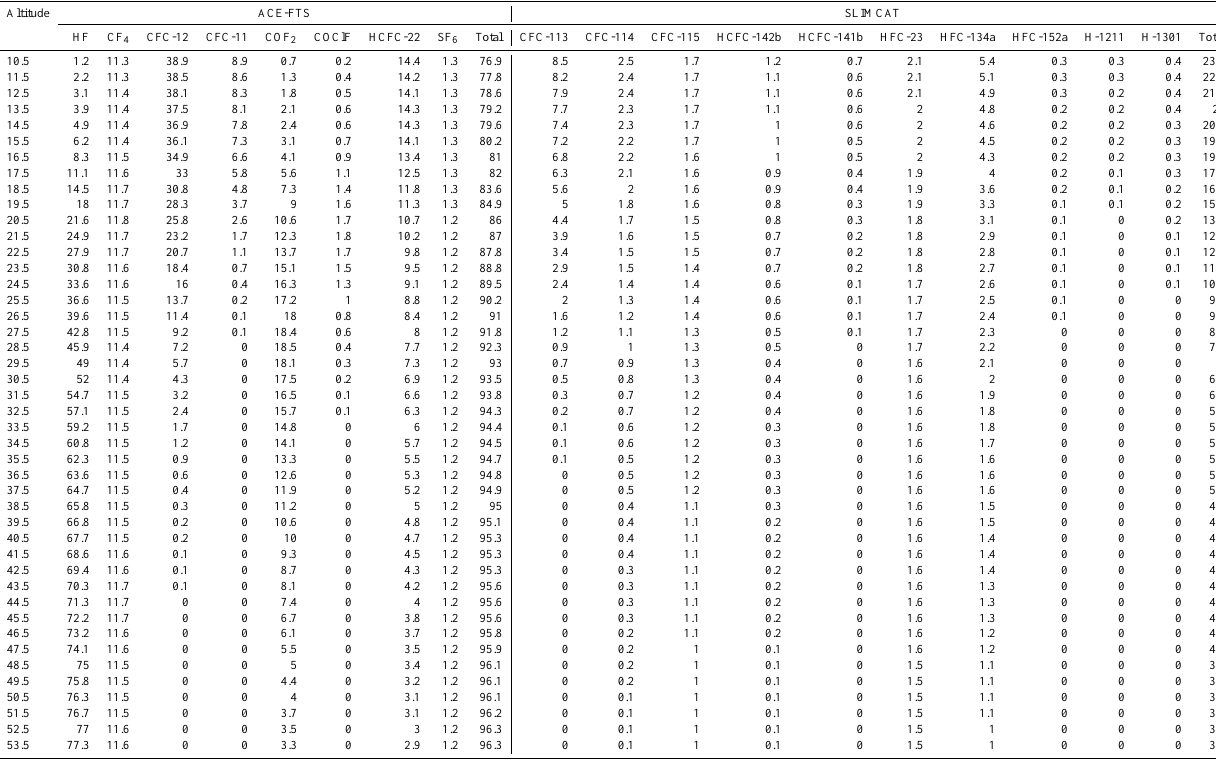
Table A1. The percentage contribution of each species to the total fluorine budget in the latitude bands between 70 ◦ N and 30 ◦ N. Altitude ACE-FTS SLIMCAT HF CF 4 CFC-12 CFC-11 COF 2 COClF HCFC-22 SF 6 Total CFC-113 CFC-114 CFC-115 HCFC-142b HCFC-141b HFC-23 HFC-134a HFC-152a H-1211 H-1301 Total